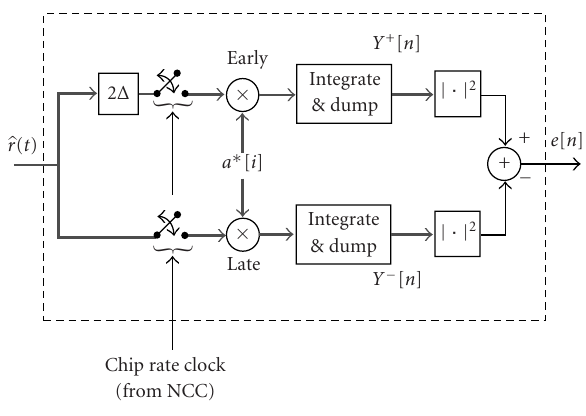
Figure 4: Single-antenna noncoherent timing error detector.